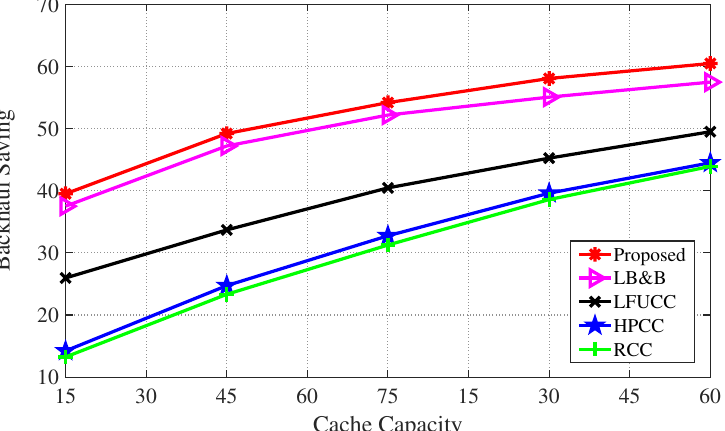
Figure 8. Impact of increasing cache capacity on backhaul saving when N = 50, F = 400, and γ =